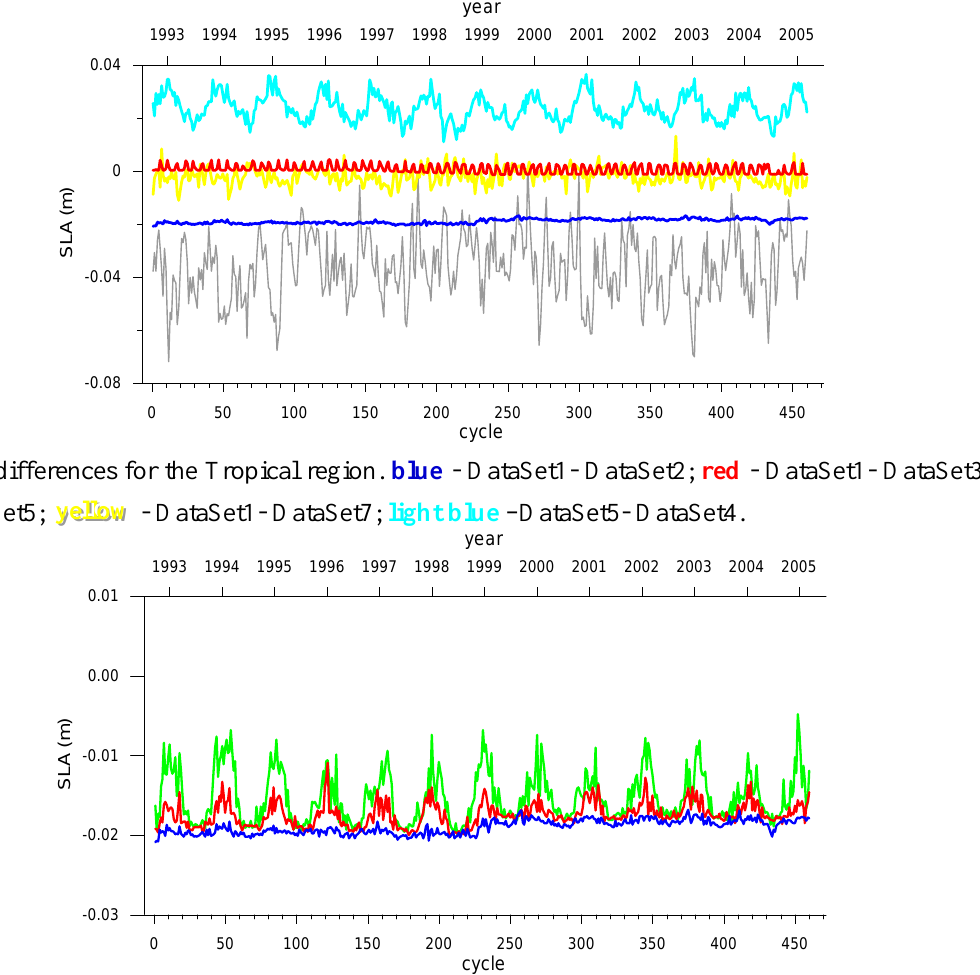
Figure 5. SLA differences DataSet1-DataSet2 (different SSB models: Chambers – Labroue). blue - Tropical; red : Sub-Tropical; green: Sub-Arctic.